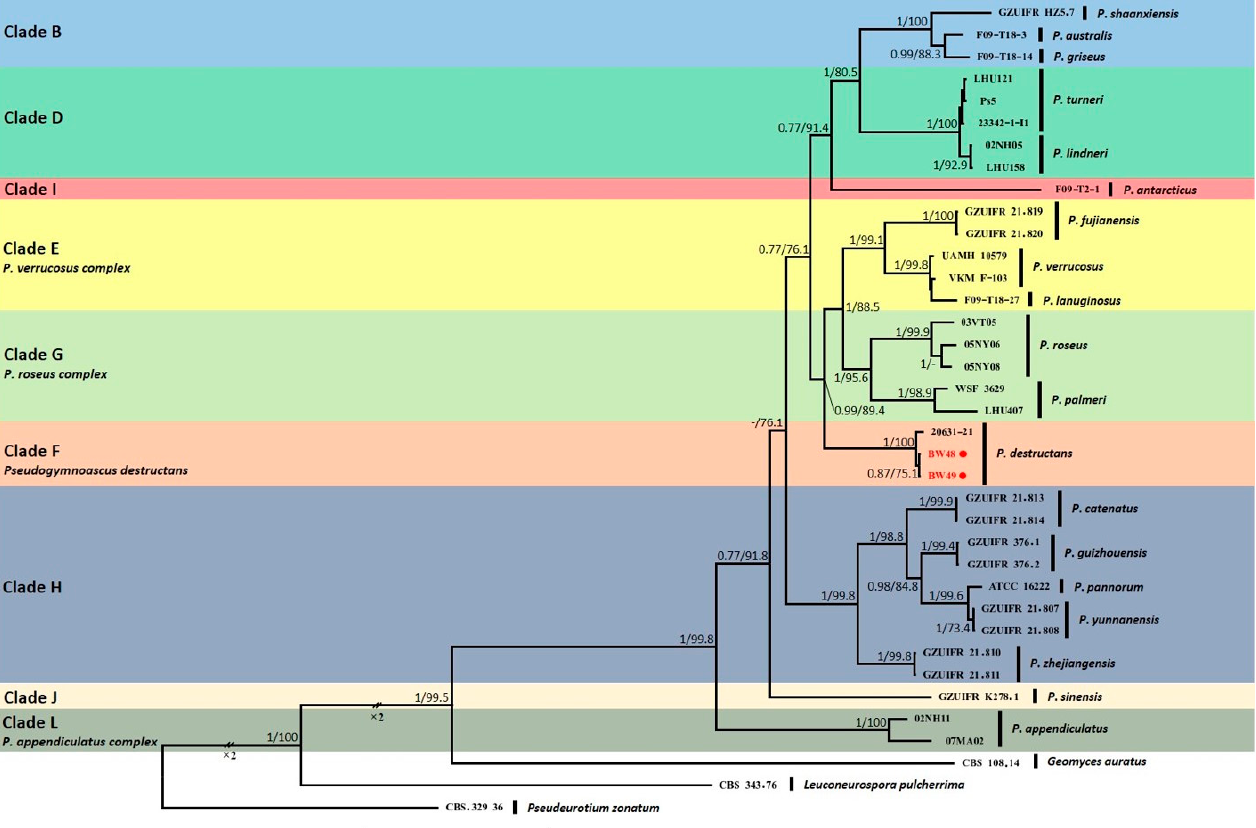
Figure 4. Bayesian inference phylogenetic tree of Pseudogymnoascus genus generated from the concatenated dataset of five loci (ITS, LSU, TEF1, RPB2, and MCM7). Bayesian posterior probabilities (BPPs) and significant maximum likelihood bootstrap (BS) values are indicated by branches. Only clades that received 0.75 BPPs and 70% BS simultaneously were considered strongly supported and presented at the branches. Clades were identified using clade nomenclature (A to M), formally defined by Minnis and Lindner [15]. The scale bar indicates 0.03 nucleotide changes per site. Pd is highlighted in red and with a red spot.